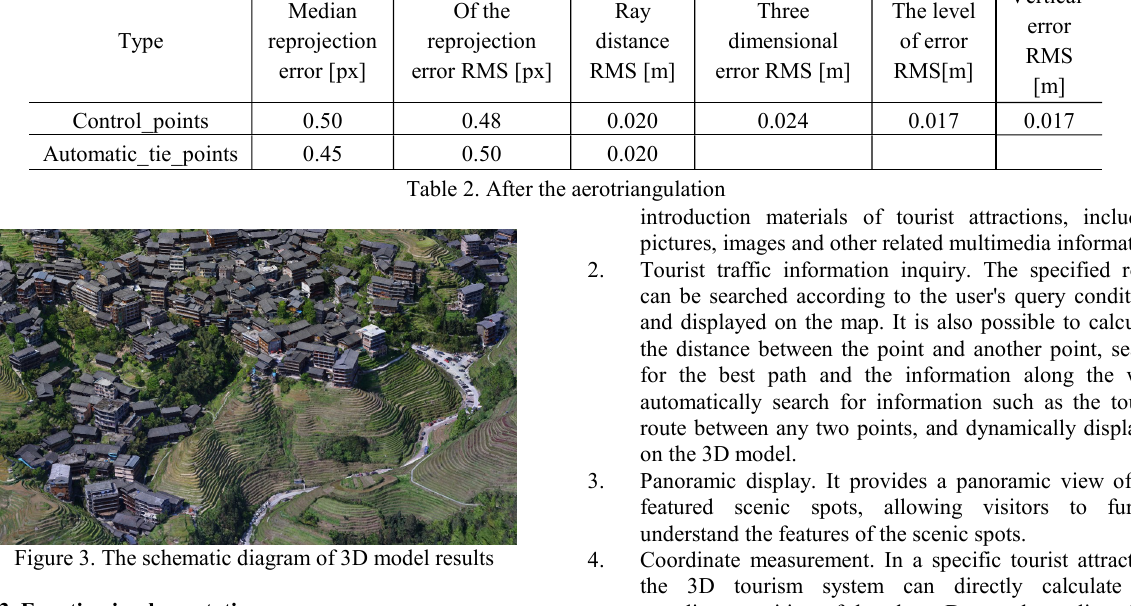
Table 1. Before aerotriangulation